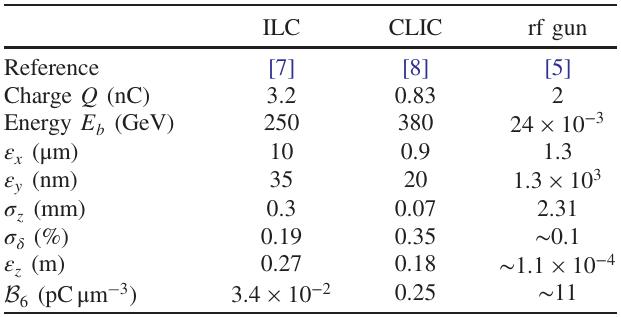
TABLE I. Comparison of beam-parameter requirements for two conventional LC designs with parameters achieved in an rf photoinjector. The longitudinal emittance is evaluated as ε ≃ γσ σ z z δ . The rf photoinjector used as an example is based on the L-band rf gun of the European X-ray FEL.